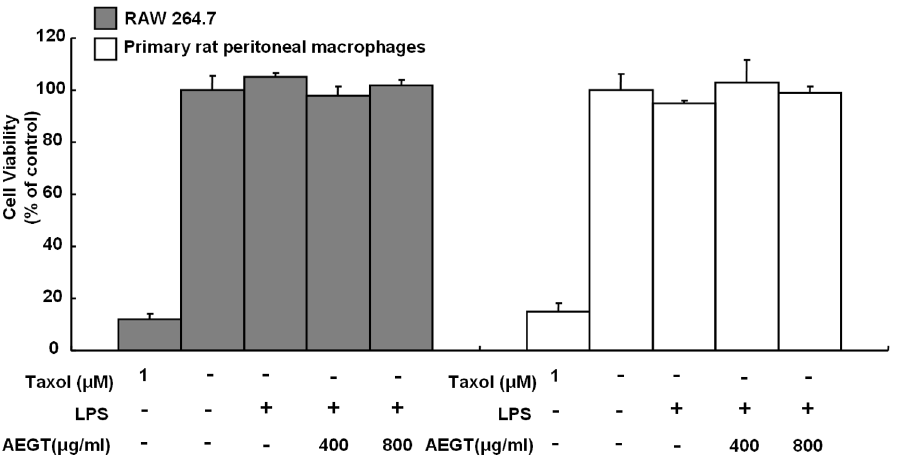
Figure 1. Effect of AEGT on the cell viability of RAW 264.7 cells and primary rat peritoneal macrophages. Cells were seeded in a 96-well plate and treated with 400 or 800 m g/ml AEGT for 1 h, and then incubated with 1 m g/ml LPS for 24 hours. Cell viability was measured by the MTA assay. Treatment of 1 m M Taxol served as a positive control. Error bars indicate the means 6 SD of three independent experiments. * P , 0.05; ** P , 0.01.